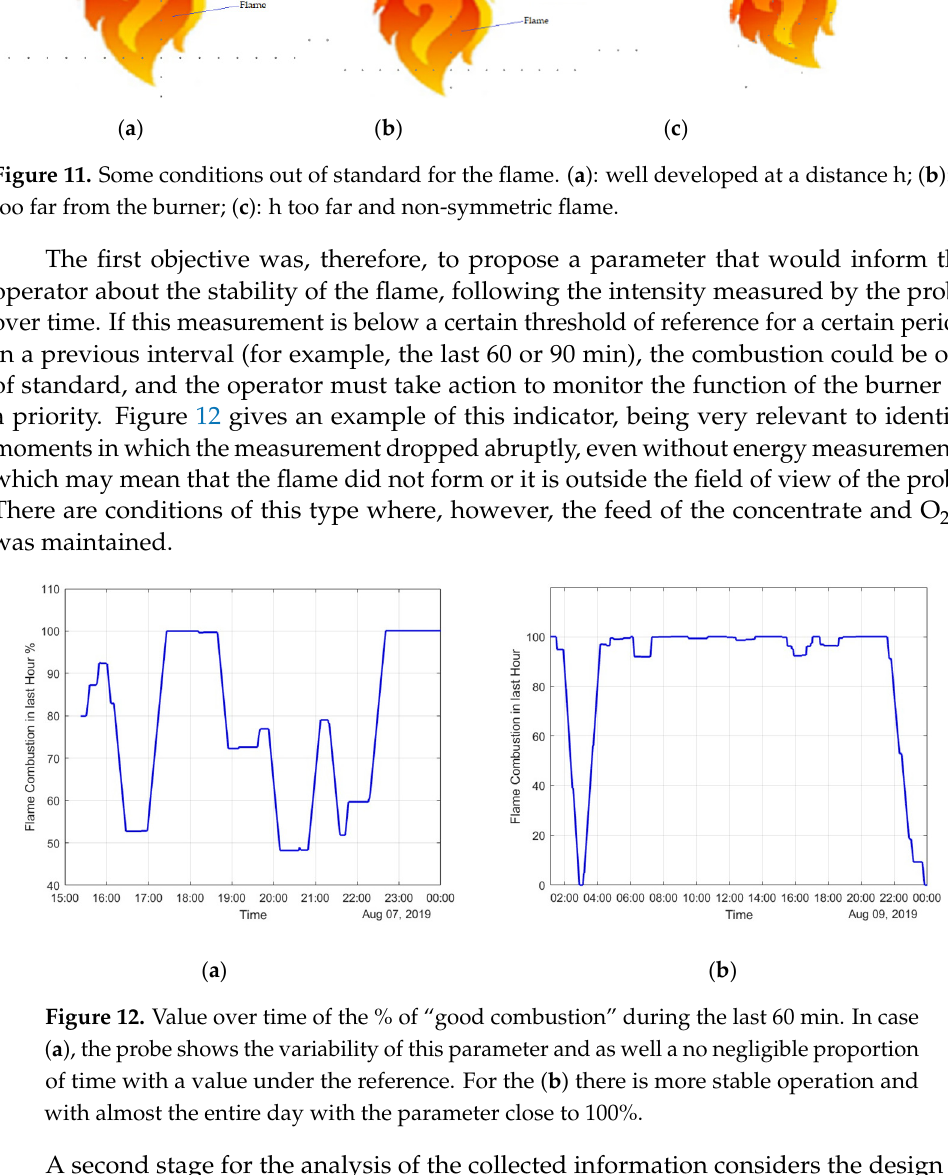
Figure 10. Position of the probe in a industrial flash smelting burner.